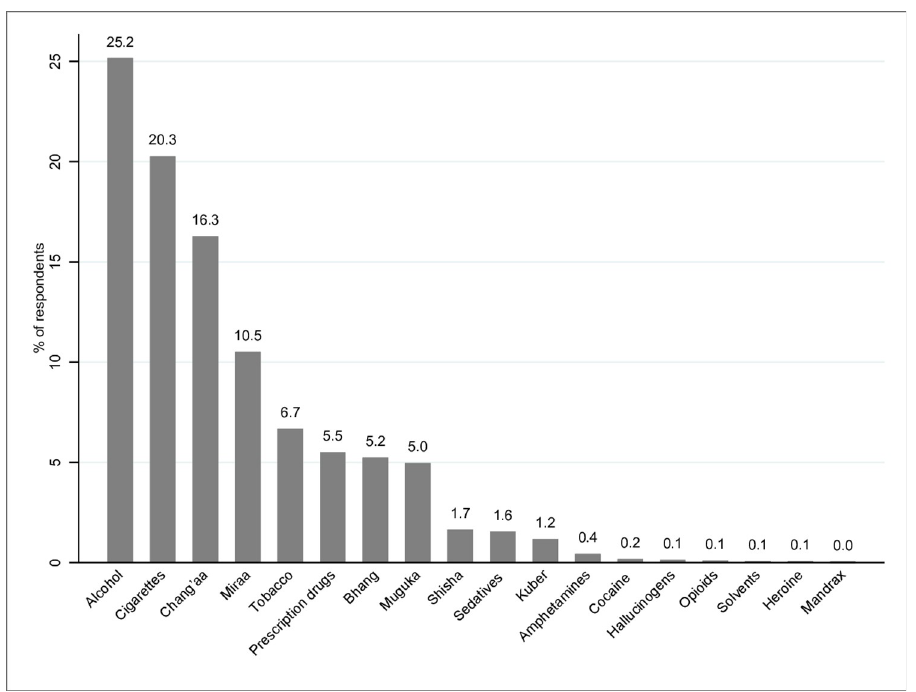
Fig 3. Overall types of drugs and substances abused by the study participants.